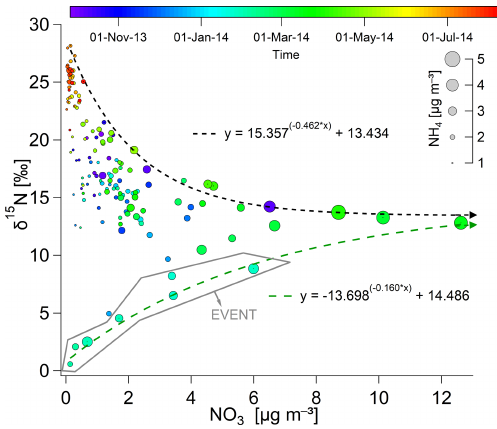
Figure 4. Relationships of δ 15 N of TN vs. NO − The larger circles indicate higher NH + scale reflects the time of sample collection.